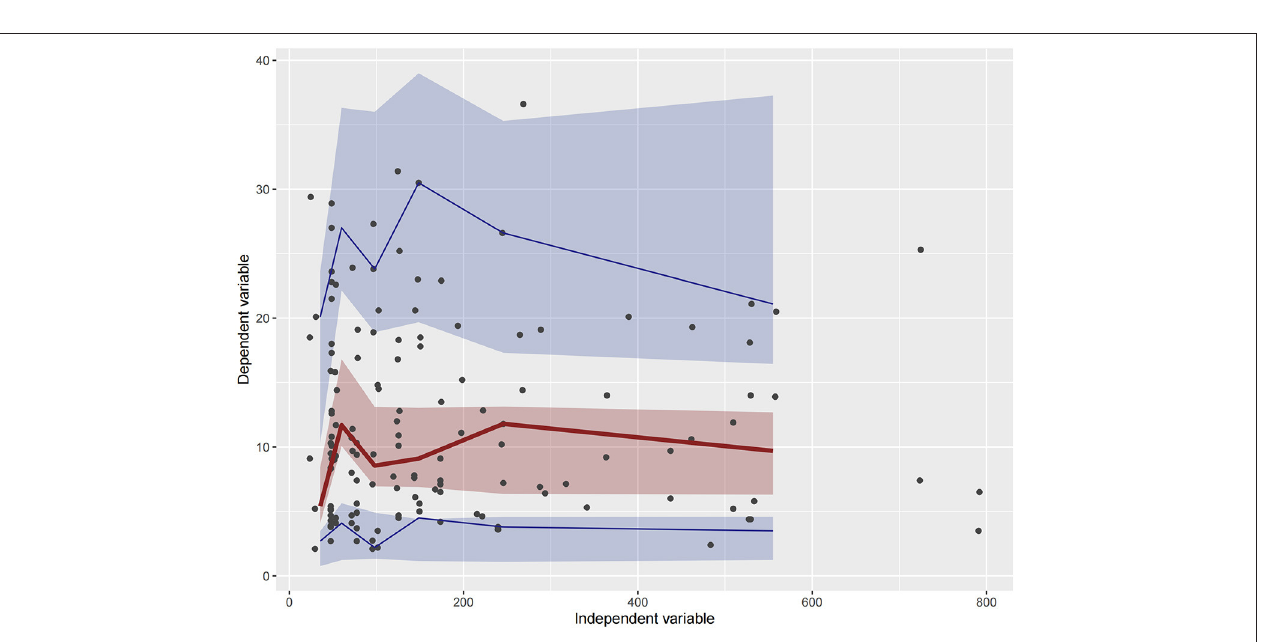
and its concentration in kidney tubules and kidney decreased further